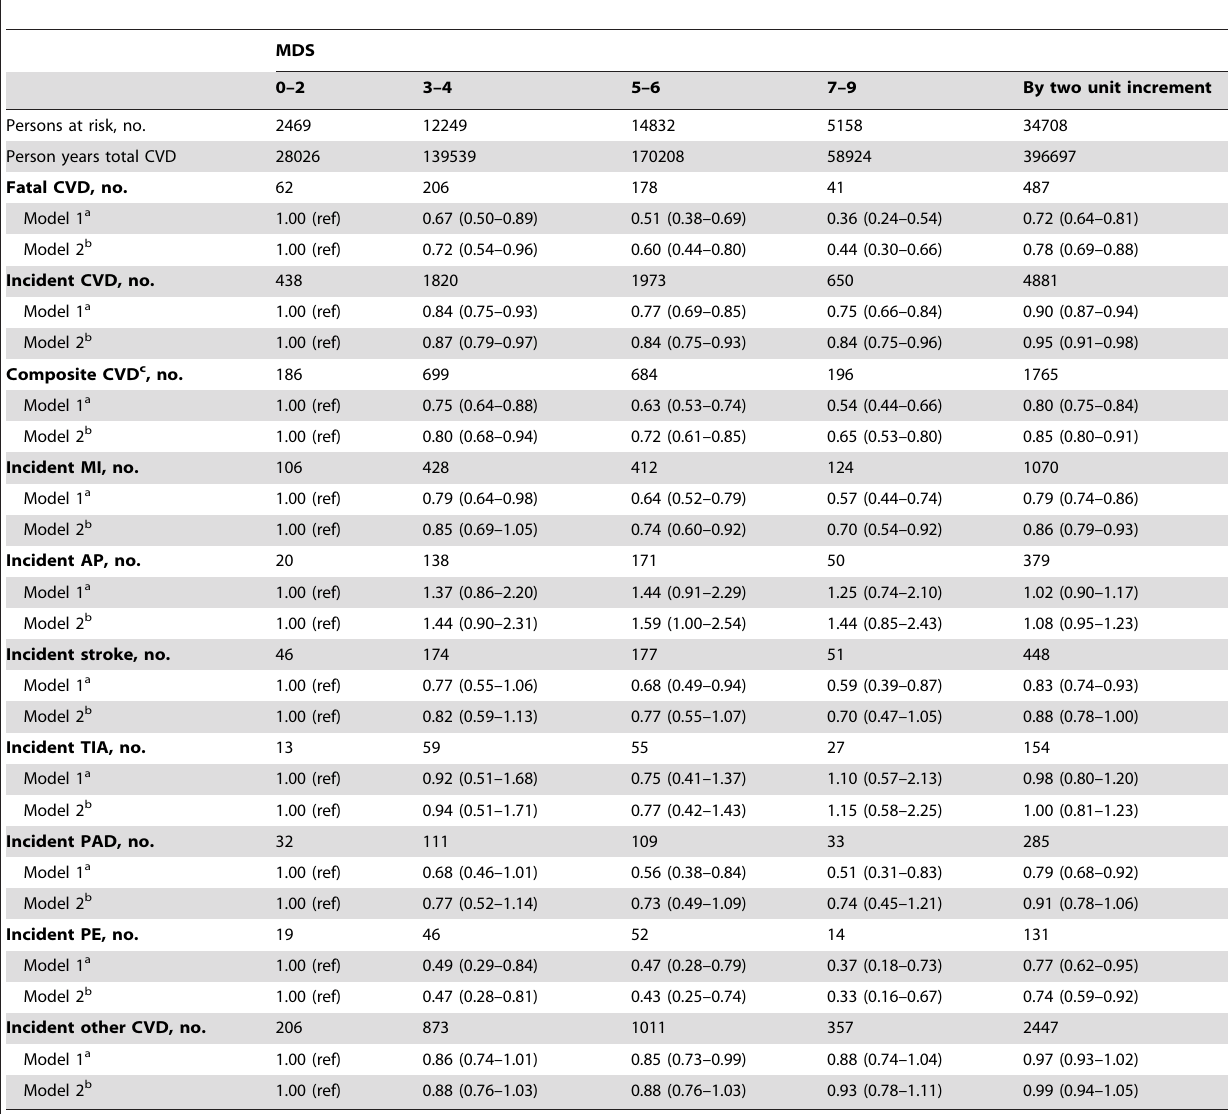
Table 2. Hazard ratios (95%CI) of specific CVD by MDS category and by two unit increment in MDS, The EPIC-NL